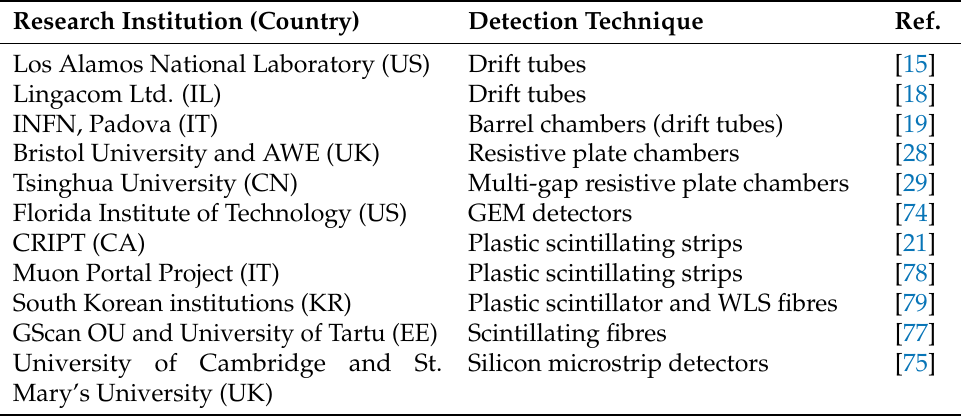
Figure 14. Schematic view of a plastic scintillator detector with a WLS fibre readout. Table 2 lists various institutions involved in the development of cosmic-ray muon tomography and detection methods. Table 2. Variety of developments in muon tomography and detection